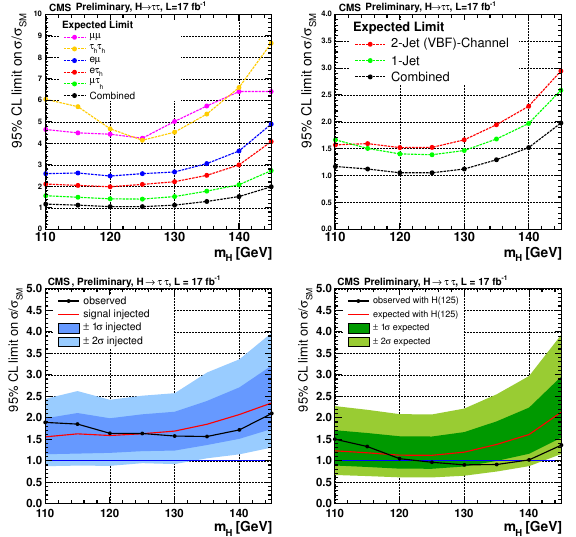
Figure 5. The sensitivity of the presented analysis expressed in terms of the expected limit. Shown are the sensitivity (upper left) split in decay channels and (upper right) split in event categories. The sensitivity per category is shown including the constraint of the background contributions in the 0-Jet event category. The sensitivity of the 1-Jet event category corresponds to the com- bination of the sub-event categories for high and low p T of the τ lepton. Also shown are two di ff erent representations of the observed and expected limit. Shown is (lower left) a compari- son of the observed limit together with the expectation for a SM Higgs boson at m H = 125 GeV and (lower right) the expected and observed 95% CL upper limit for the search of a second Higgs boson, considering the SM Higgs boson with m H = 125 GeV as